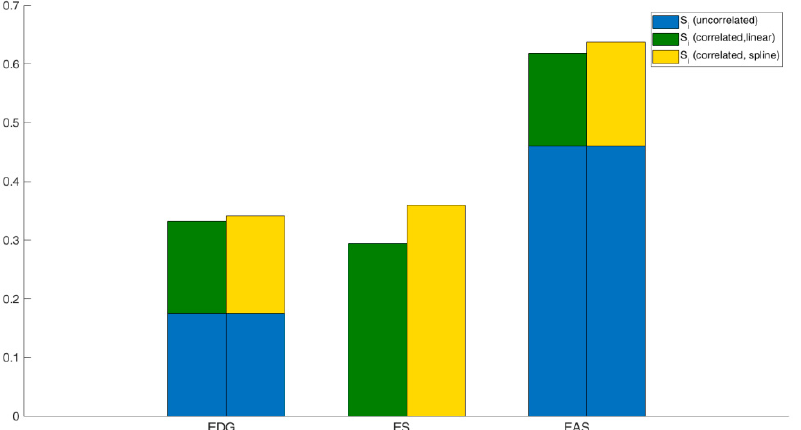
Figure 4. Penalised spline estimates of 𝑆 (cid:3036) (entire bar) broken down into 𝑆 (cid:3036)(cid:3048) (blue bar) and 𝑆 (cid:3036)(cid:3030) (green or yellow bar)* or ETI’s System Performance. EGD—Economic Development and Growth, ES—Environmental Sustainability, EAS—Energy Access and Security.